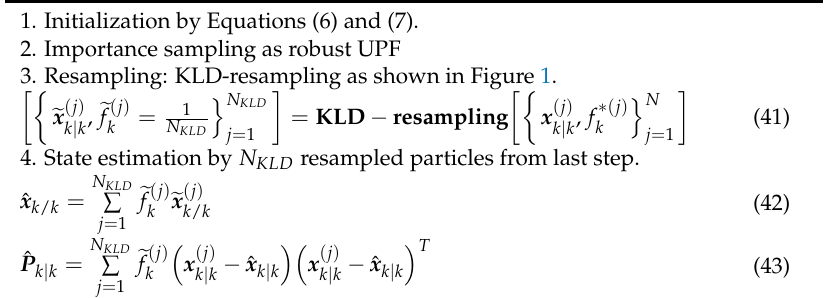
Table 3. Algorithm of the proposed maximum correntropy based unscented particle filter (MCUPF). 1. Initialization by Equations (6) and